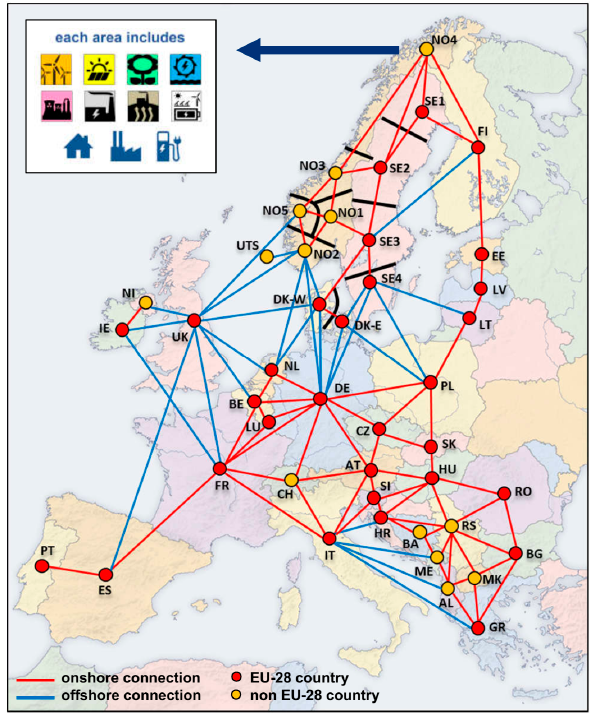
Figure 7. Schematic design of the full model in EMPS with the countries/areas and connections.